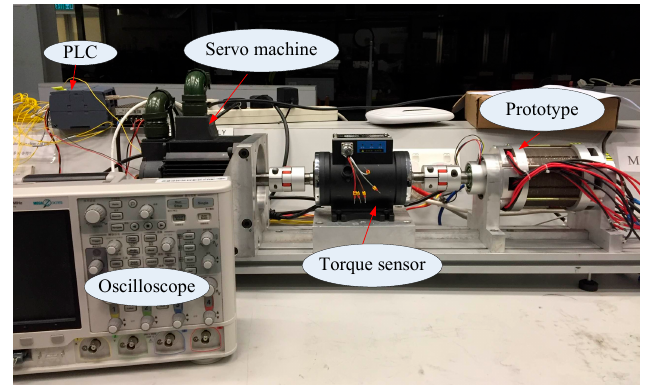
Figure 12. Test bench of the proposed DCF-HEM.